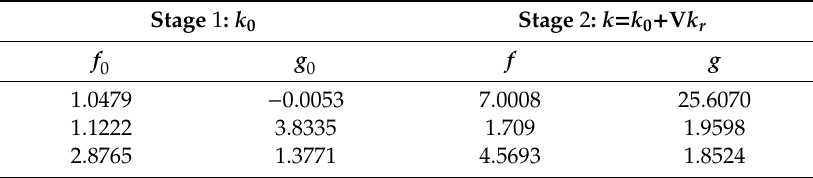
Table 6. Gains (test-case 3).